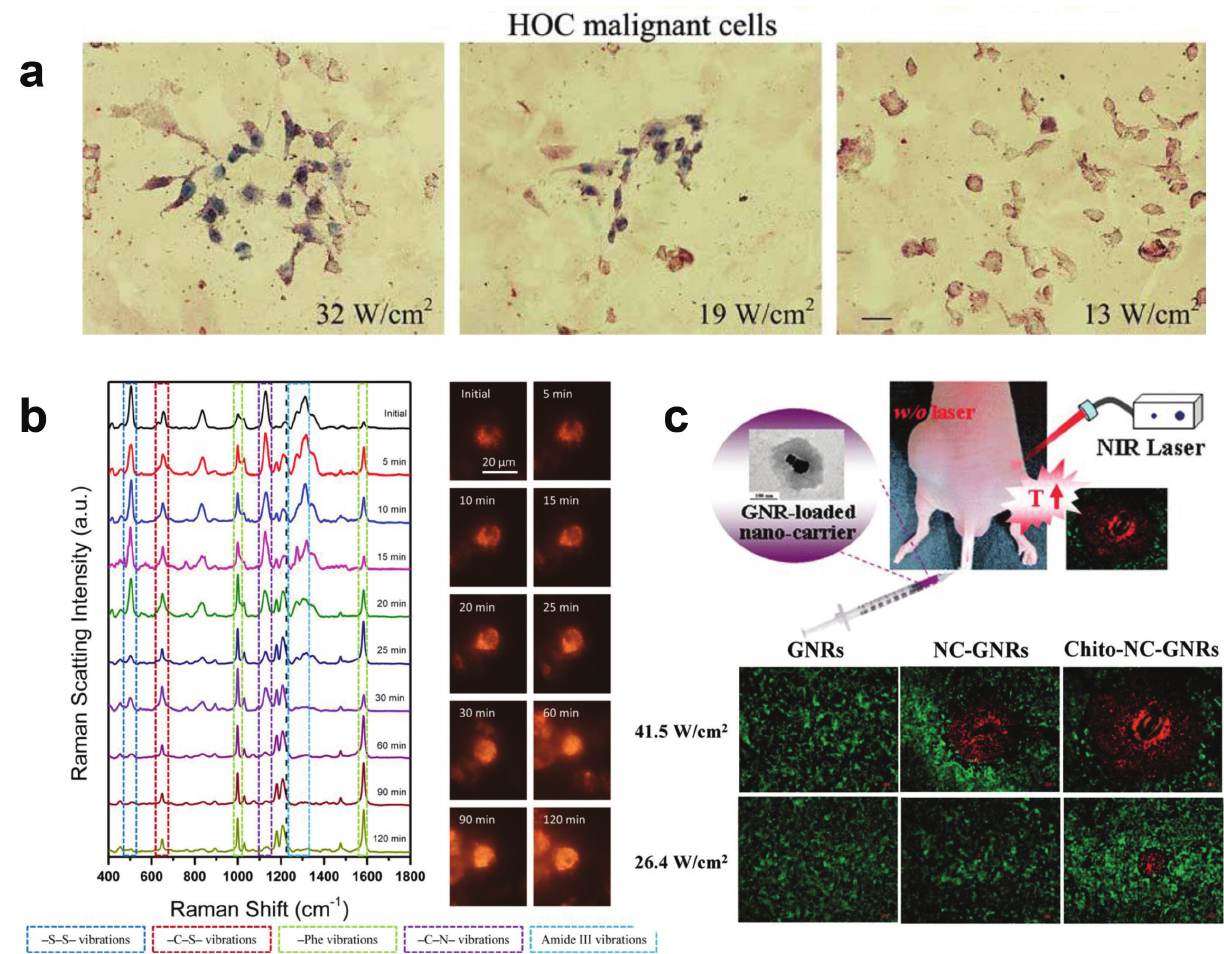
Fig. 3. (a) Oral squamous carcinoma cell lines (HOC malignant cells) loaded with AuNPs irradiated at different laser powers and were killed at and above 19 W/cm 2 (44). (b) Time-dependent surface-enhanced Raman scattering (SERS) spectra of single HSC-3 cell during PTT (69). (c) Fluorescence images after NIR PTT on SCC7 cancer cells